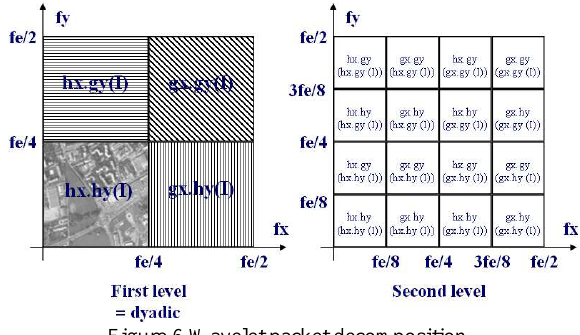
Figure 6 Wavelet packet